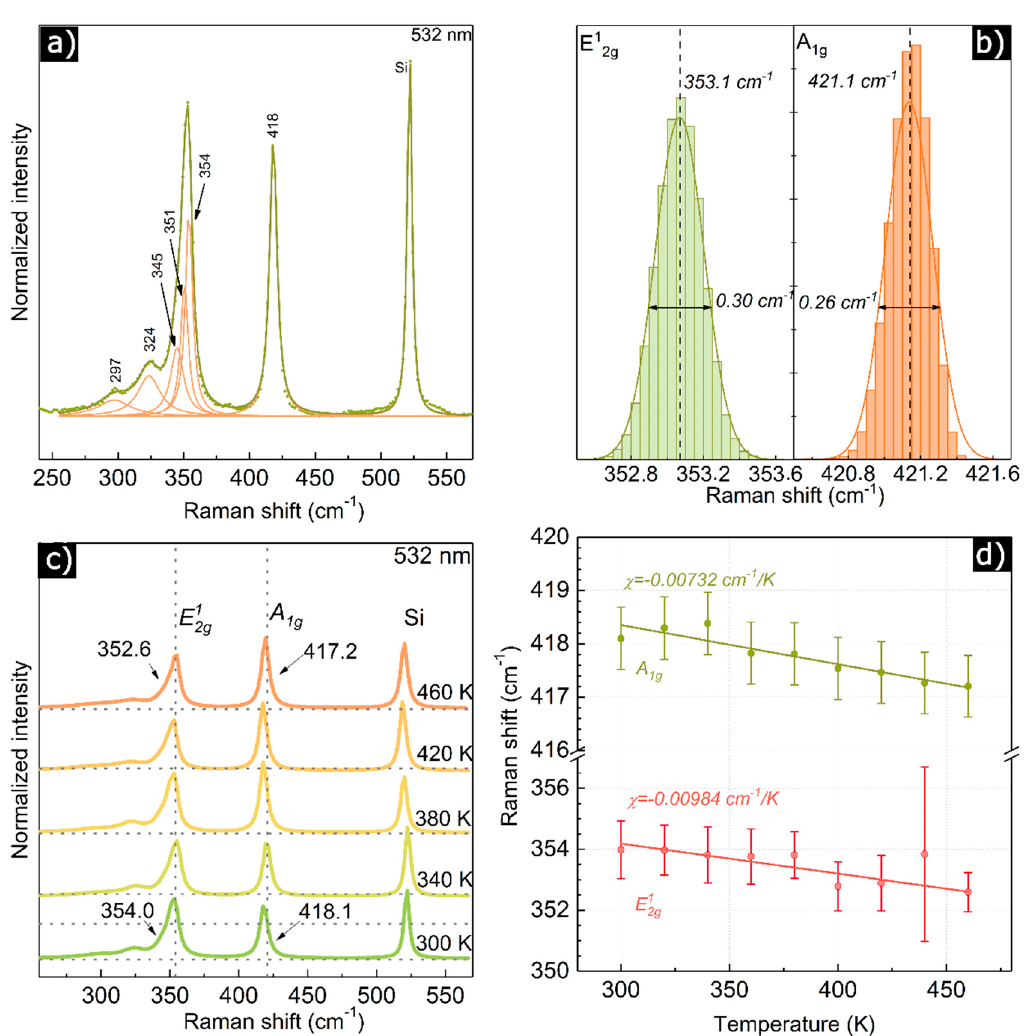
Figure 2. ( a ) A typical single Raman spectrum obtained for WS 2 , laser wavelength: λ = 532 nm, RT (room temperature); ( b ) statistical distribution of two main Raman modes in WS 2 film. The average mode positions and standard deviation are as follow: 𝑥̅ = 421.14 cm − 1 , σ = 0.13 cm − 1 for the A 1g mode, 𝑥̅ = 353.07 cm − 1 , σ = 0.13 cm − 1 for the E 12g mode; ( c ) temperature-dependent Raman spectra, ( d ) detailed temperature analysis for two main modes in Raman spectrum for WS 2